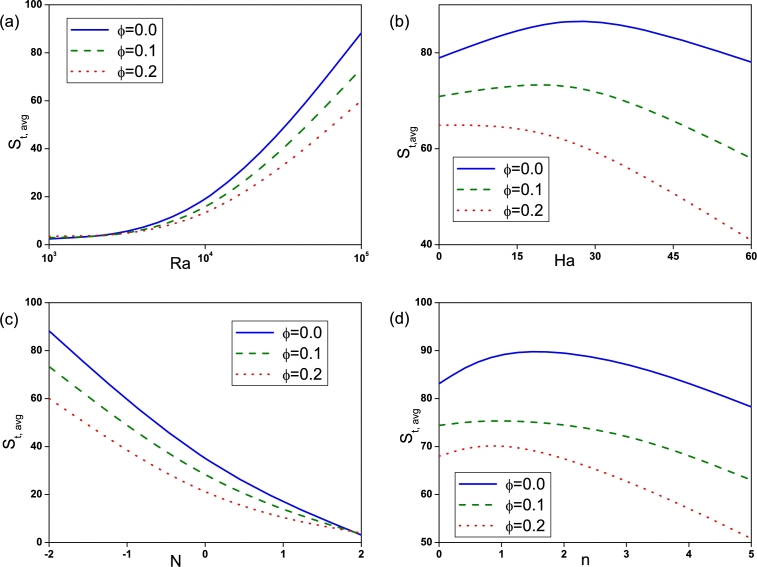
Variation of total entropy generation (St,avg) for different (a) Ra, (b) Ha, (c) N and (d) n.